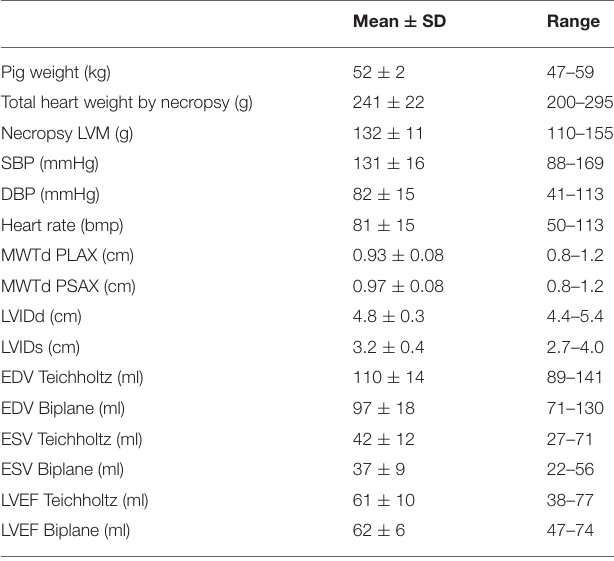
TABLE 2 | Baseline